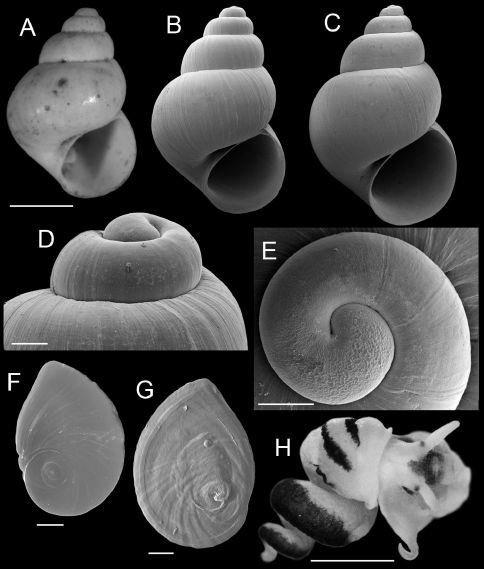
Shells, opercula and animal, Marstonia comalensis. A Lectotype, ANSP 91323 B, C Shells, USNM 874932, USNM 874926 D Lateral view of shell apex, USNM 874932 E Protoconch, USNM 874926 F, G Opercula (outer, inner sides), USNM 874926 H Relaxed, alcohol-preserved preserved male (dorsal view), showing distinctive pigment bands on the pallial roof, USNM 874926. Scale bars A–C, H, 1.0 mm; D, E, 100 µm; F, G, 200 µm.